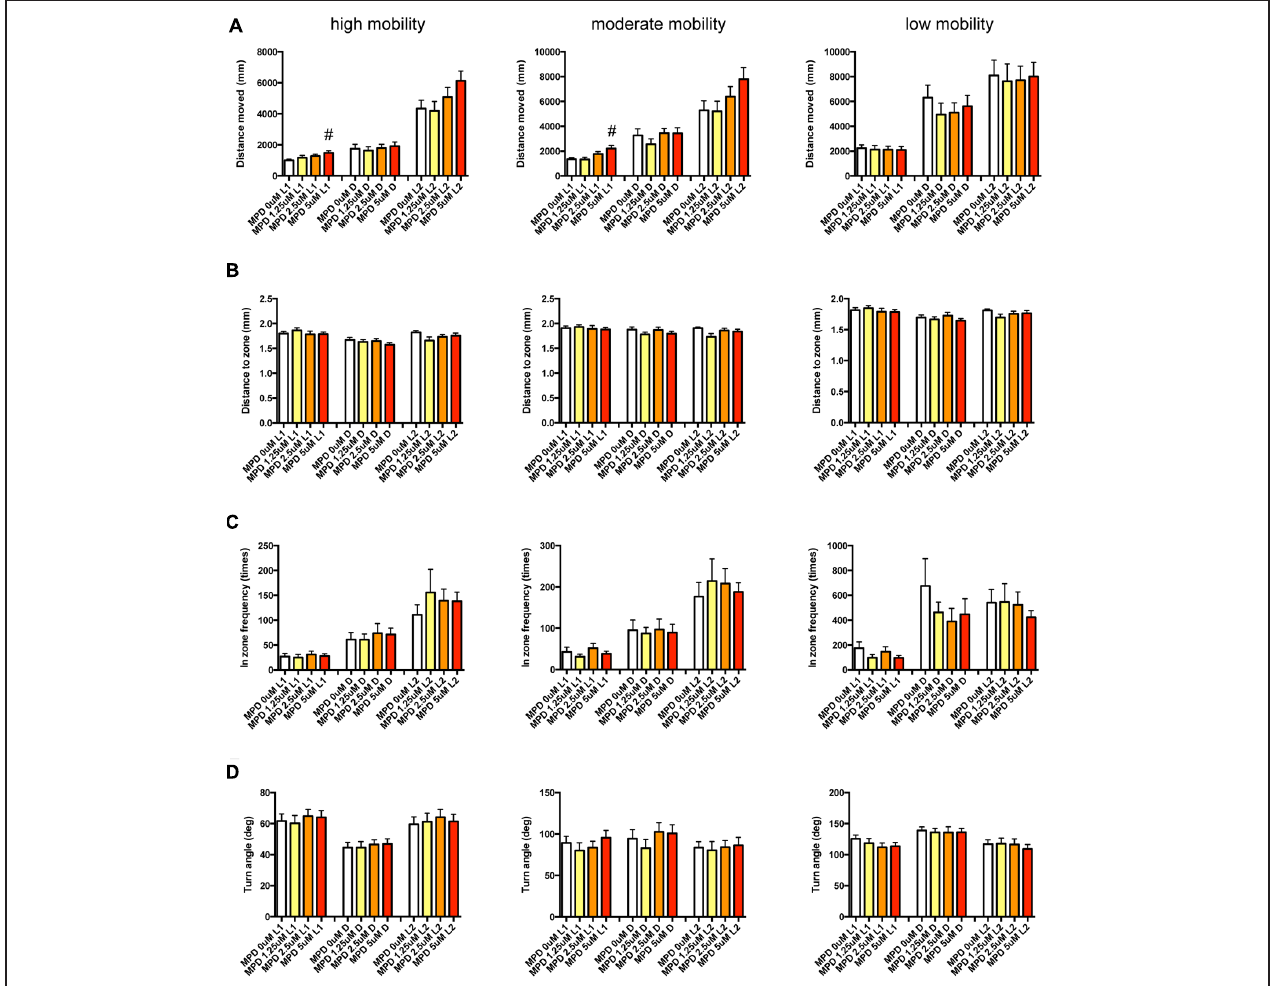
FIGURE 11 | Behavioral profiling of zebrafish treated with methylphenidate. The behavior of zebrafish treated with methylphenidate from 9 to 10 dpf was classified into three groups based on mobility. Distance moved (A) , distance to zone (B) , in zone frequency (C) , and turn angle (D) at L1, D, and L2 periods are indicated for each mobility classification. The data are represented as means with the standard error of mean. # p < 0.05 vs. 0 μ